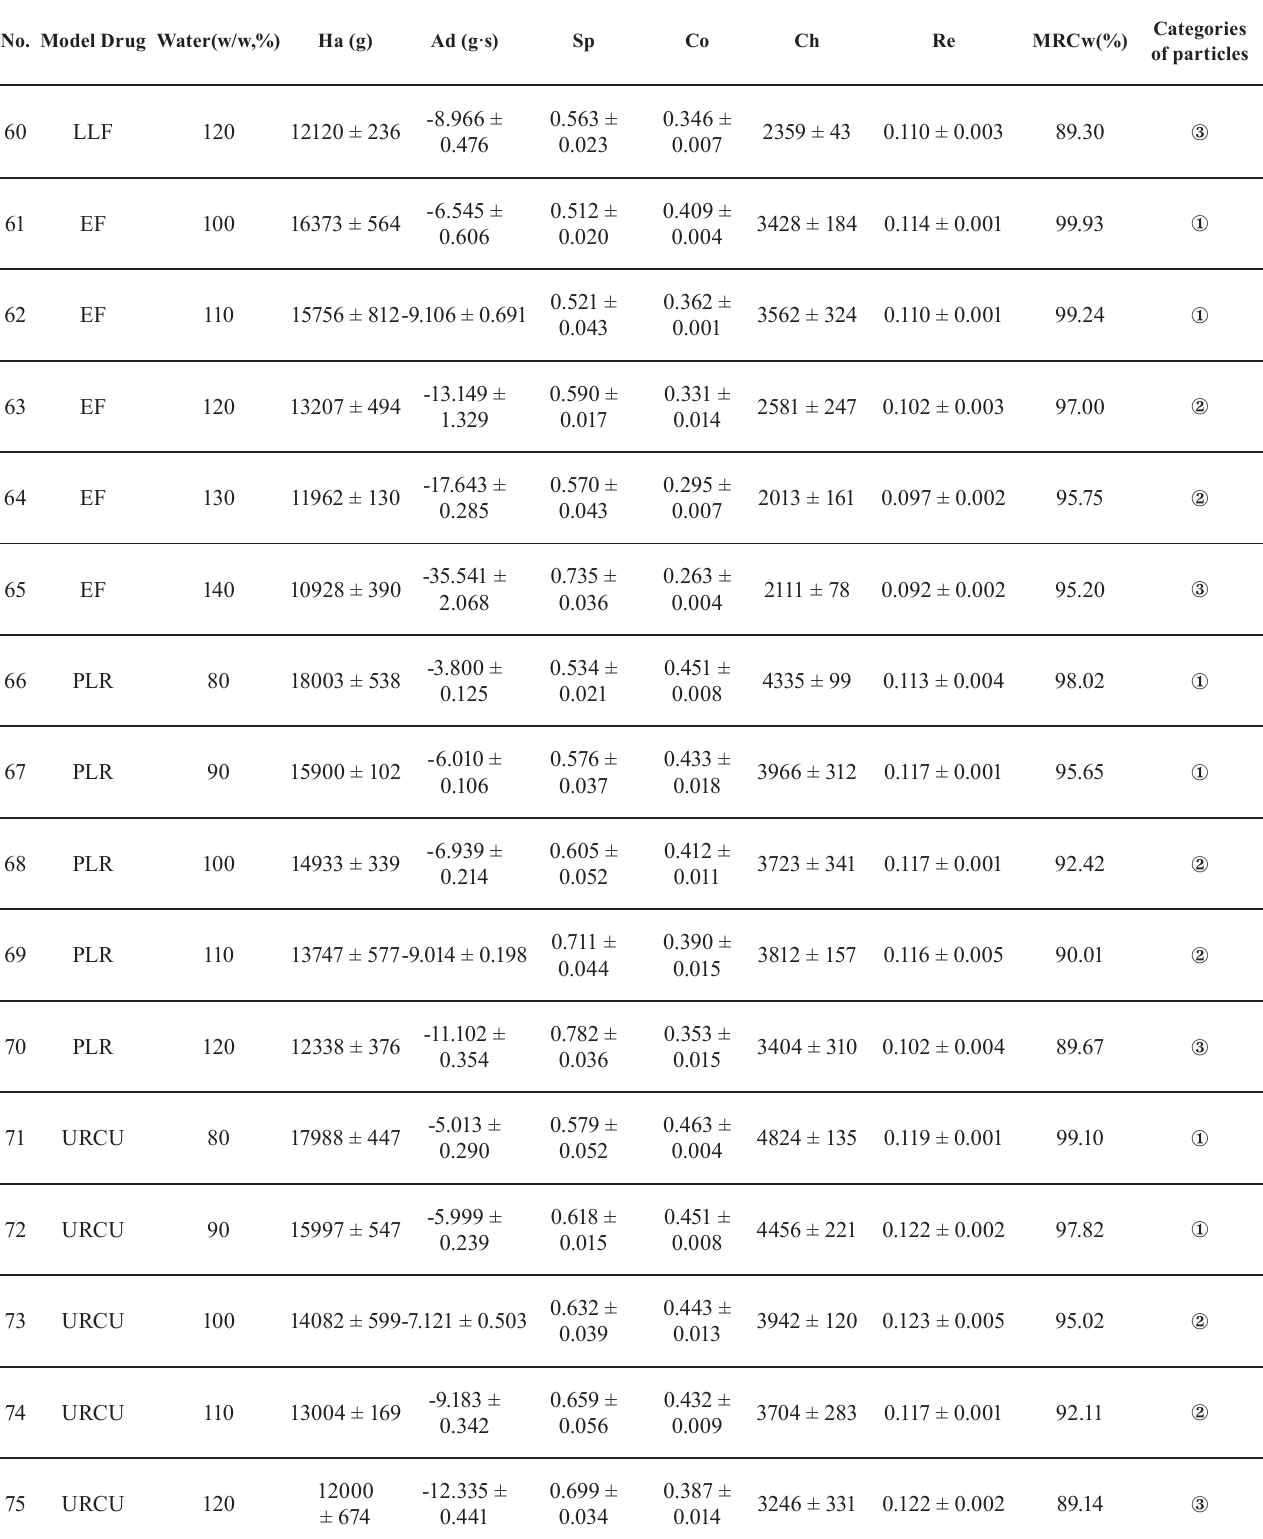
TABLE II – The physical properties of wet masses and categories of pellets from 100 formulations (n=3, x ± s)